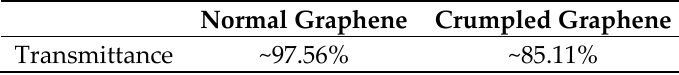
Figure 2. ( a ) SEM image of the crumpled graphene; ( b ) AFM image of the crumpled graphene with the height profile of the cross section shown in the inset; ( c ) Raman spectra of normal and crumpled graphene samples. The 2D peak shows a frequency red shift; ( d ) Positions of Raman G and 2D peaks obtained from 5 arbitrary positions on the graphene samples. The inset shows the OM image of the normal and the crumpled graphene samples on the silicone film. The orange gridlines indicate the original size of the graphene sample, and the dark region inside the gridline of crumpled graphene shows the reduction in the area to 1/4 of the initial size. Table 1. Transmittance of normal and crumpled graphene (550